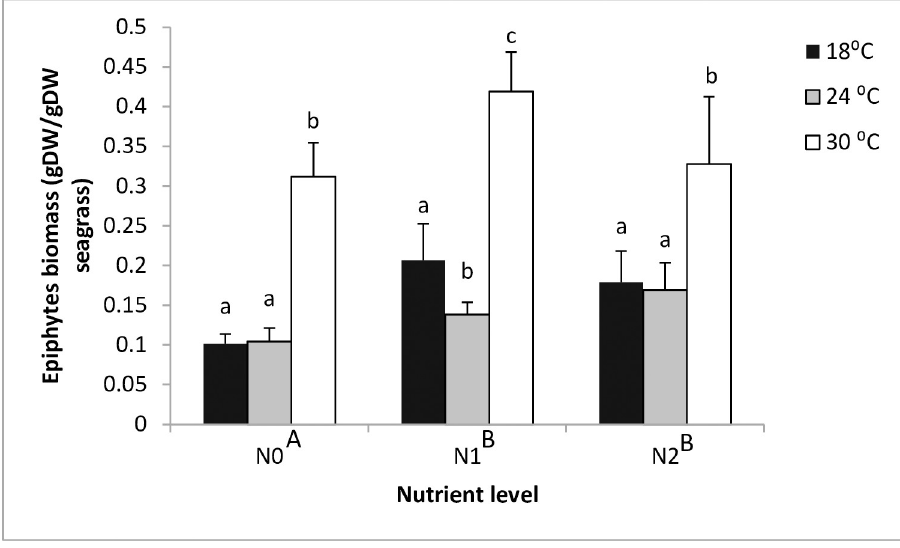
Fig 3. Main and interactive effects of temperature and nutrient treatments on epiphytes biomass. Value are mean ± SE, n = 3. Different letters above bars denote differences between temperature levels within nutrient treatments. Different capital letters adjacent to nutrient levels denote differences among nutrient